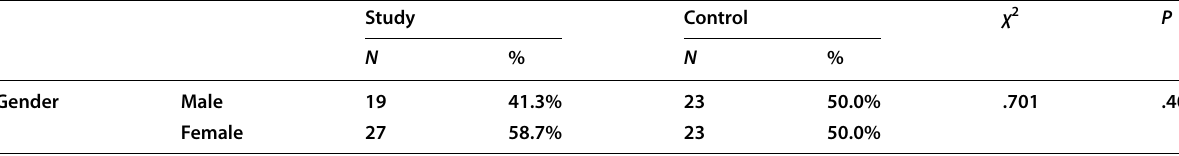
Table 2 Gender distribution in the study and control groups